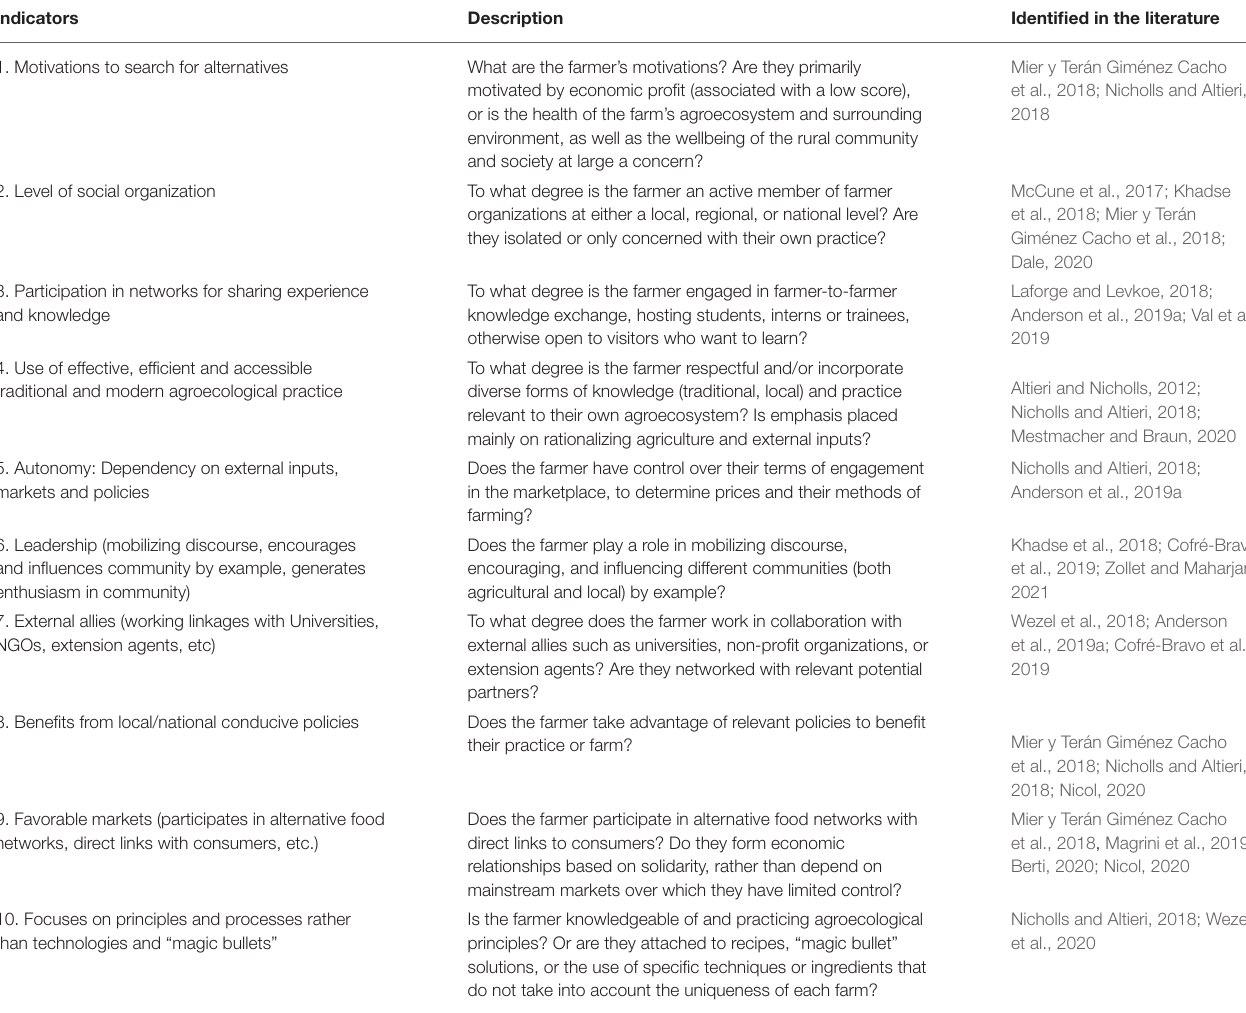
TABLE 1 | Ten indicators to assess the amplification potential of selected farms and farmers.